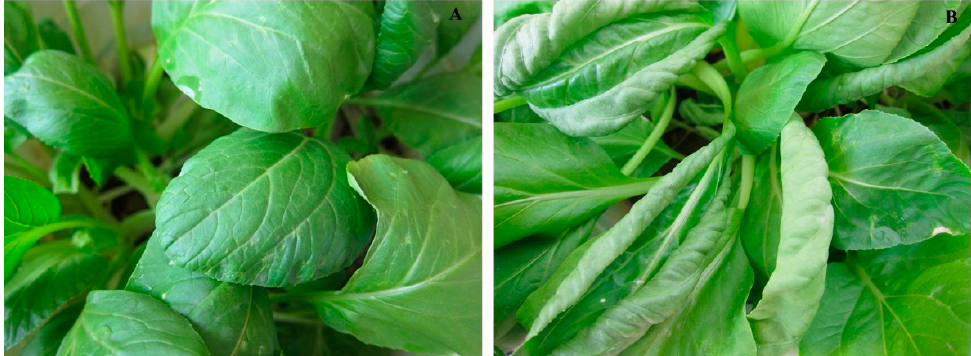
Figure 3. Phytotoxicity symptoms of B. chinensis caused by the application of profenofos/ triazophos with TiO 2 /Ce treatment. ( A ) profenofos/triazophos; ( B ) profenofos/triazophos + TiO 2 /Ce.